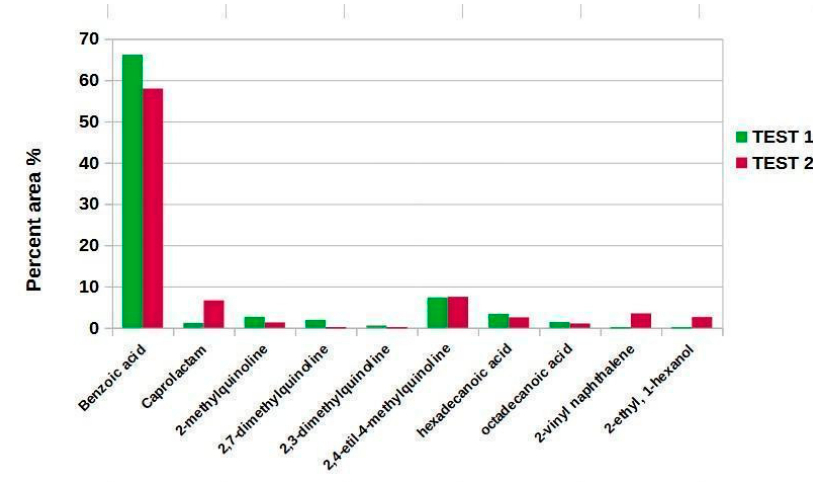
Figure 8. Comparison between the relative percentage areas of compounds present in the oils of Tests 1 and 2.